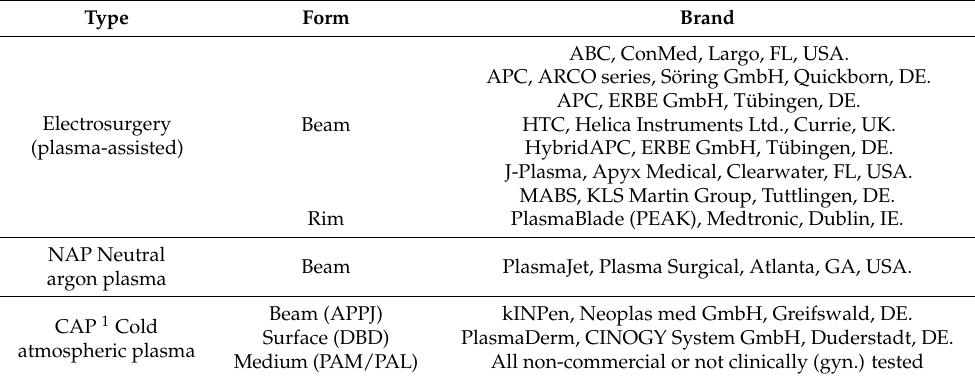
Table 1. An overview of clinically (gyn.) tested plasma-based devices, grouped by plasma type. Type Form Brand